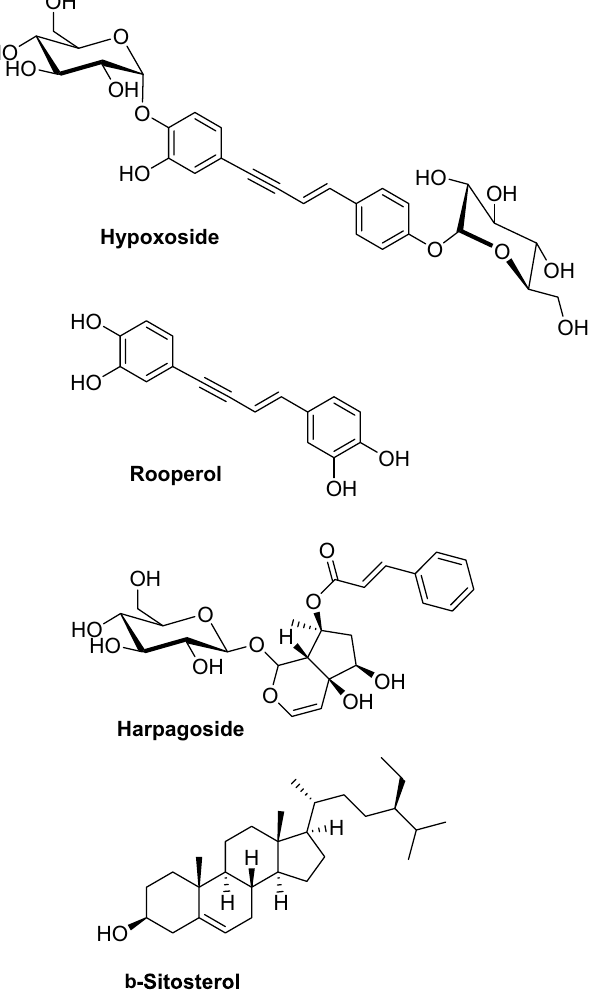
Figure 1. Structures of major known secondary metabolites in Hypoxis